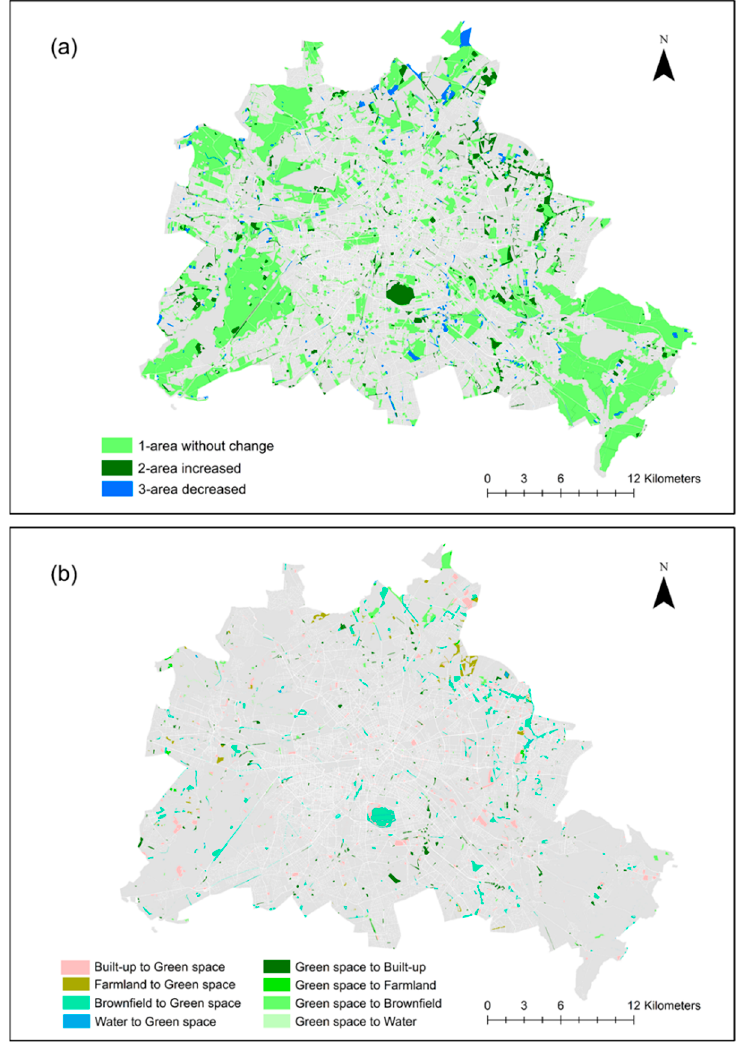
Figure 2. ( a ) Changes in public UGS between 2005 and 2015; ( b ) land use changes. Table 1. Changes in public UGS from 2005 to 2015 in 12